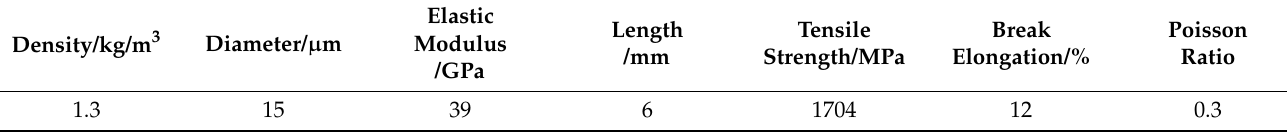
Table 3. Basic performance index of PVA fiber.